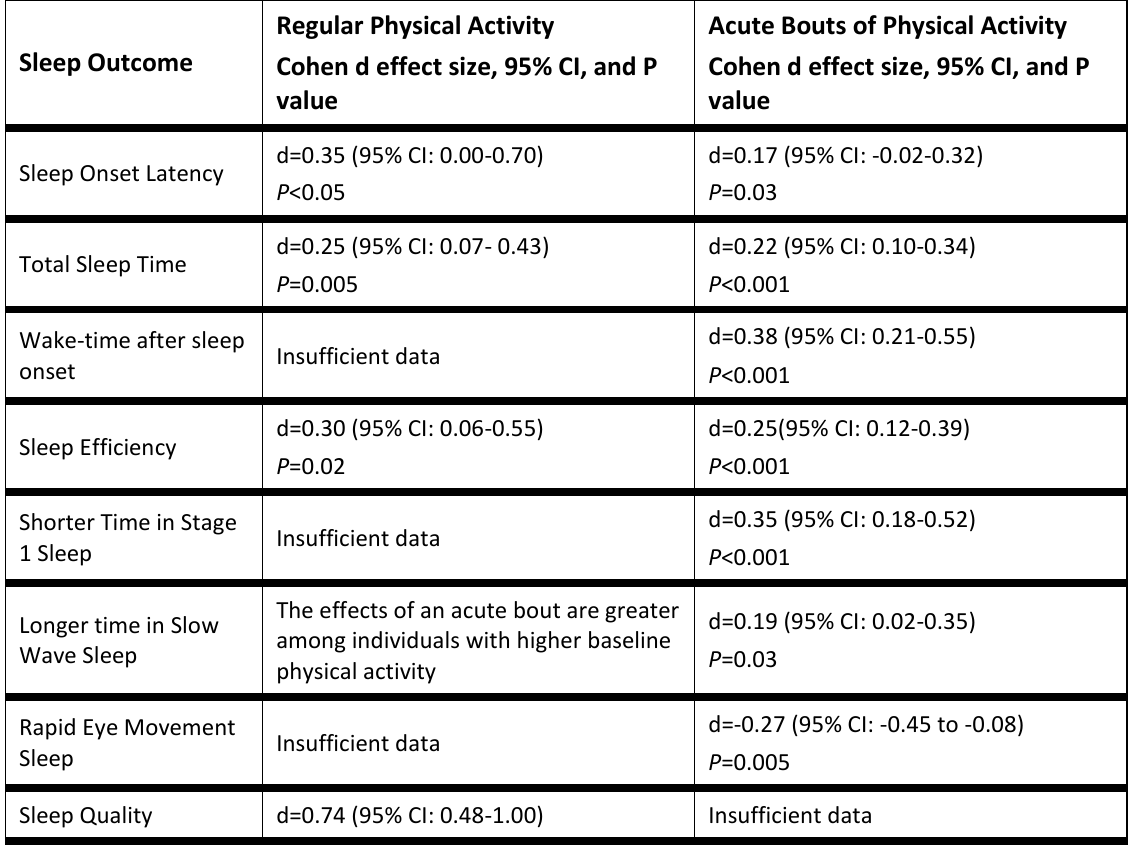
Table F3-2. Effect on Sleep Outcomes in Adults of Habitual Moderate-to-Vigorous Physical Activity Compared to Controls and Acute Bouts of Moderate-to-Vigorous Physical Activity Compared to